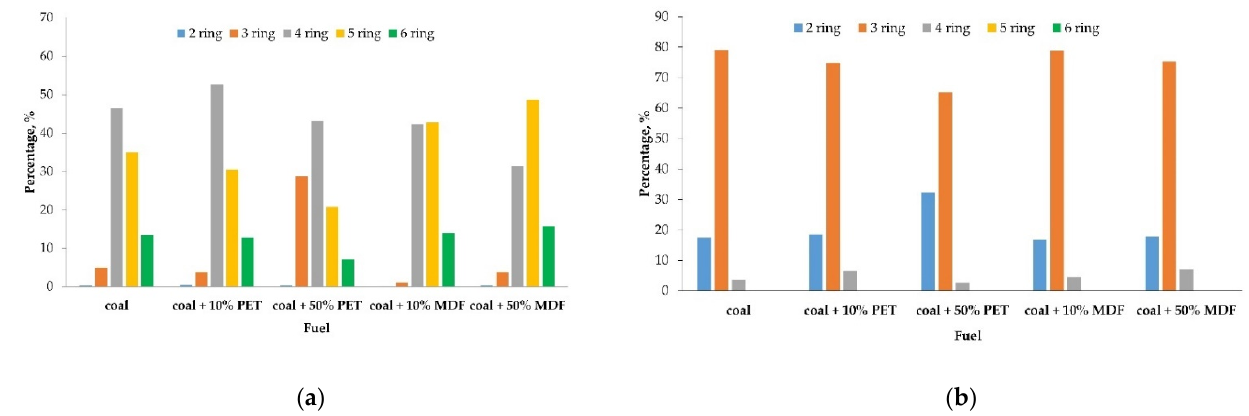
Figure 7. Composition of PAH emissions in relation to ring numbers: ( a ) PM; ( b ) gas phase.